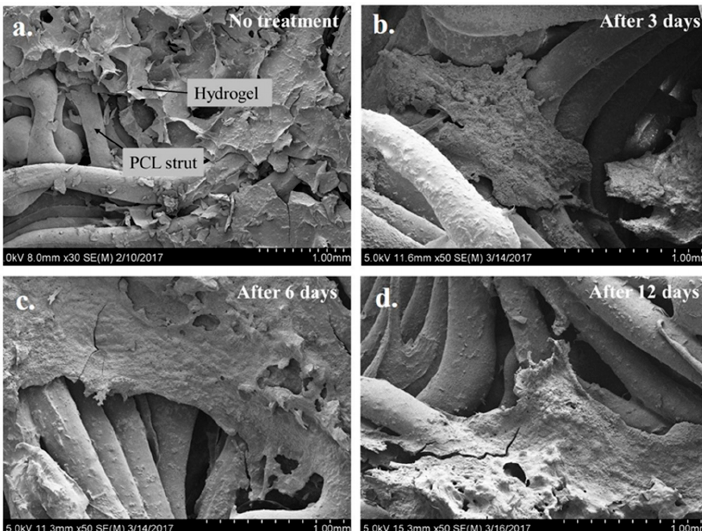
Figure 5. Low magnification SEM images of freeze-dried PCL-gel samples without SBF ( a ) and with SBF treatment for 3 ( b ), 6 ( c ), and 12 days ( d ). The SBF treated samples showed homogenous apatite layer over the hydrogel as well as PCL struts with an increasing amount of apatite deposition with time. A crack in apatite layer in ( c , d ) is due the strain generated due to drying of the samples.